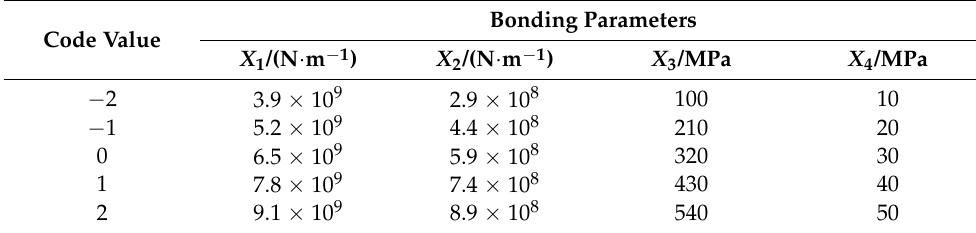
Table 3. Factors and levels of epidermal bonding model simulation tests.